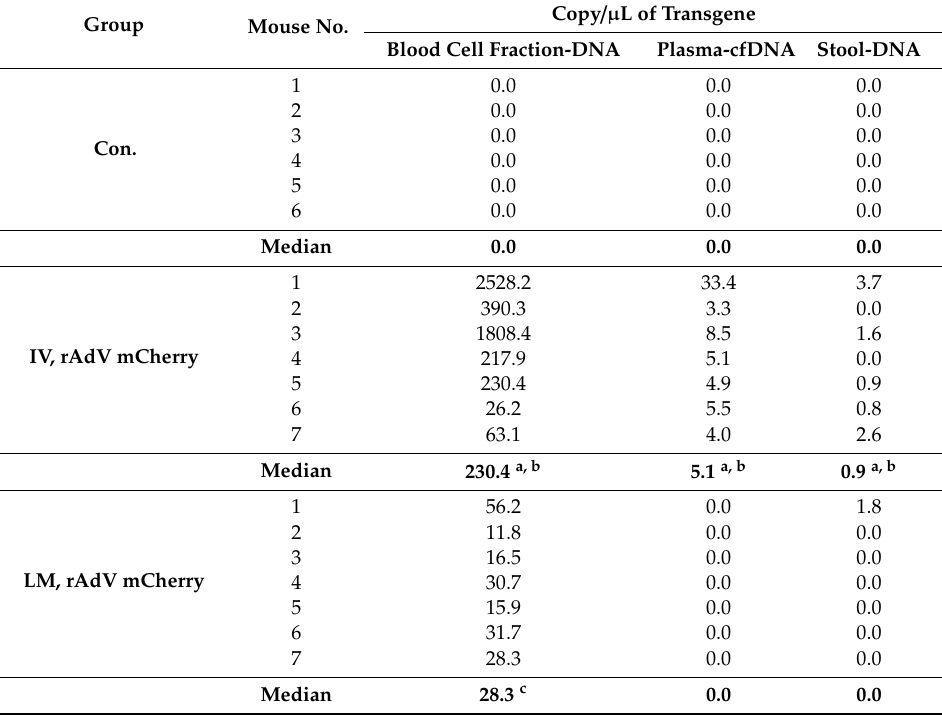
Table 3. Detection of transgene fragments from qPCR . A high number of transgene fragments was detected in the blood cell fraction DNA in the IV group. IV means intravenous injection, and LM means local muscular injection of the rAdV in the tibialis anterior (TA) muscle. a: p < 0.01 vs. control (con.) within same specimens. b: p < 0.05 vs. local injection within same specimens. c: p < 0.05 vs. con. within same specimens.